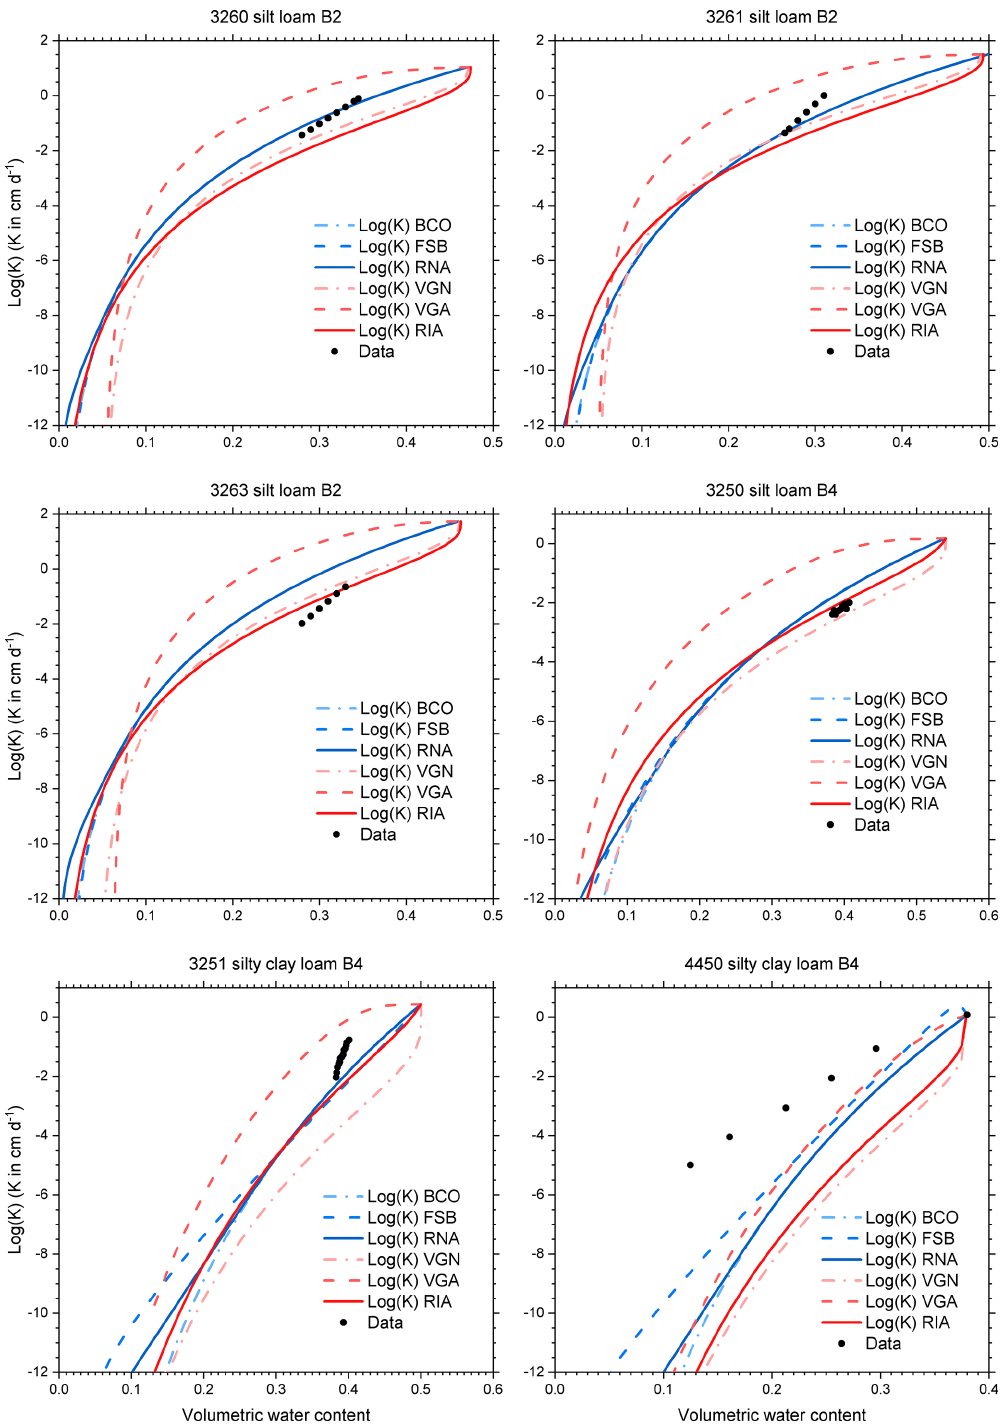
Figure C8. Conductivity data and conductivity curves derived from the retention curves of Fig. C4, according to six parameterizations for selected UNSODA soils with the B2 or B4 classification of Twarakavi et al.